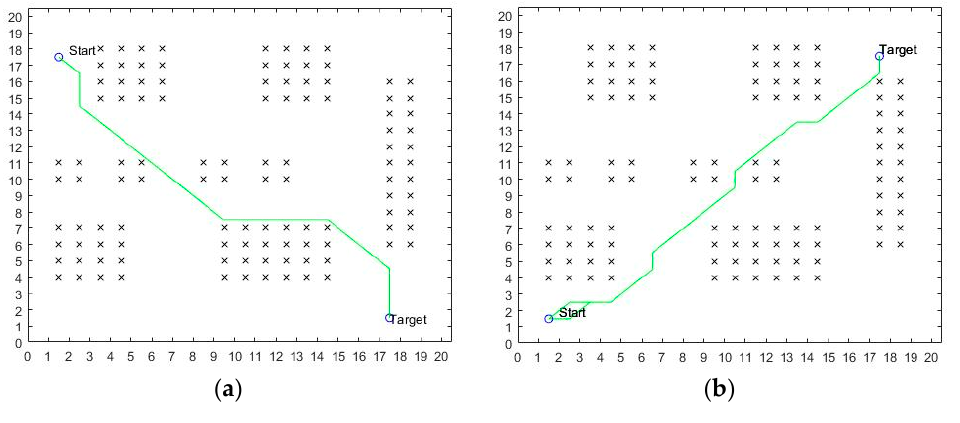
Table 5. Comparison of path-planning time based on Figures 17b and 11b (unit: s).